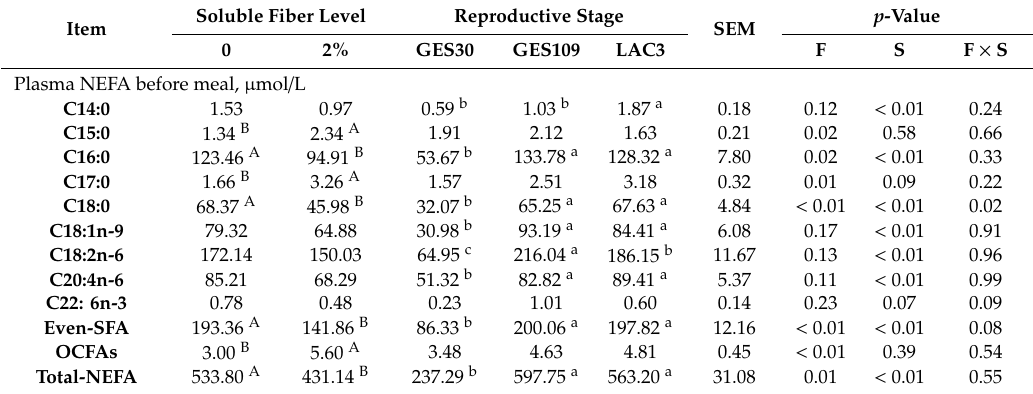
Table 1. E ff ects of soluble fiber supplementation to gestational diet on fasting plasma concentrations of non-esterified fatty acids of sows 1,2 . Soluble Fiber Level Reproductive Stage Item